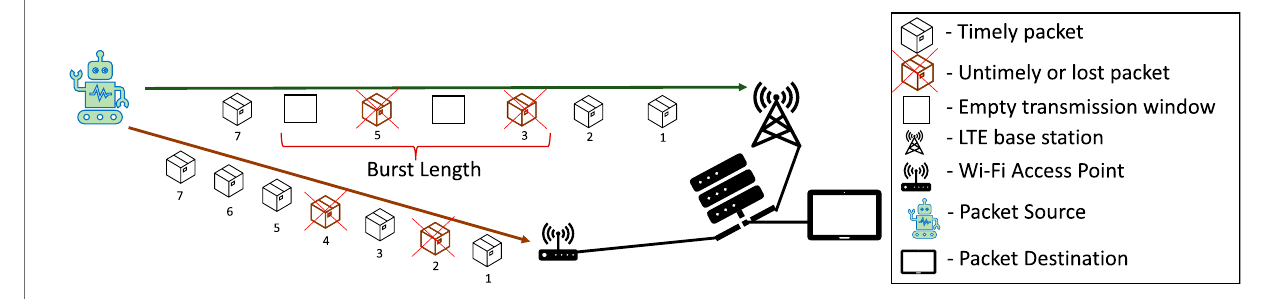
FIGURE1| Anillustrationofthescenarioinvestigatinginterfacediversitywherethesenderduplicateseachpacket.Thesenderwouldsometimesskiptransmission windows in favor of conserving energy. Here, only packet 4 was lost, packets 2, 3, 5, 6 were saved, and packets 1, 7 arrived with a redundant copy.